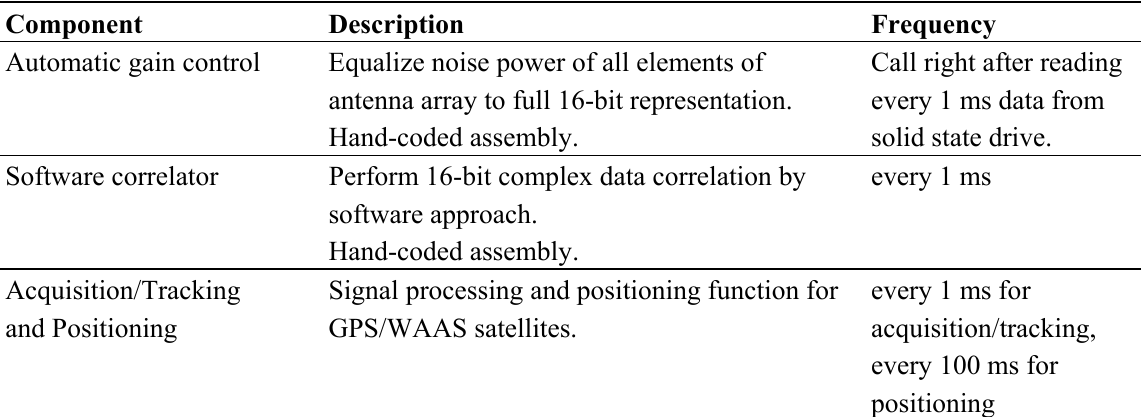
Table 1. Component list of the software architecture including short descriptions and how often each component is